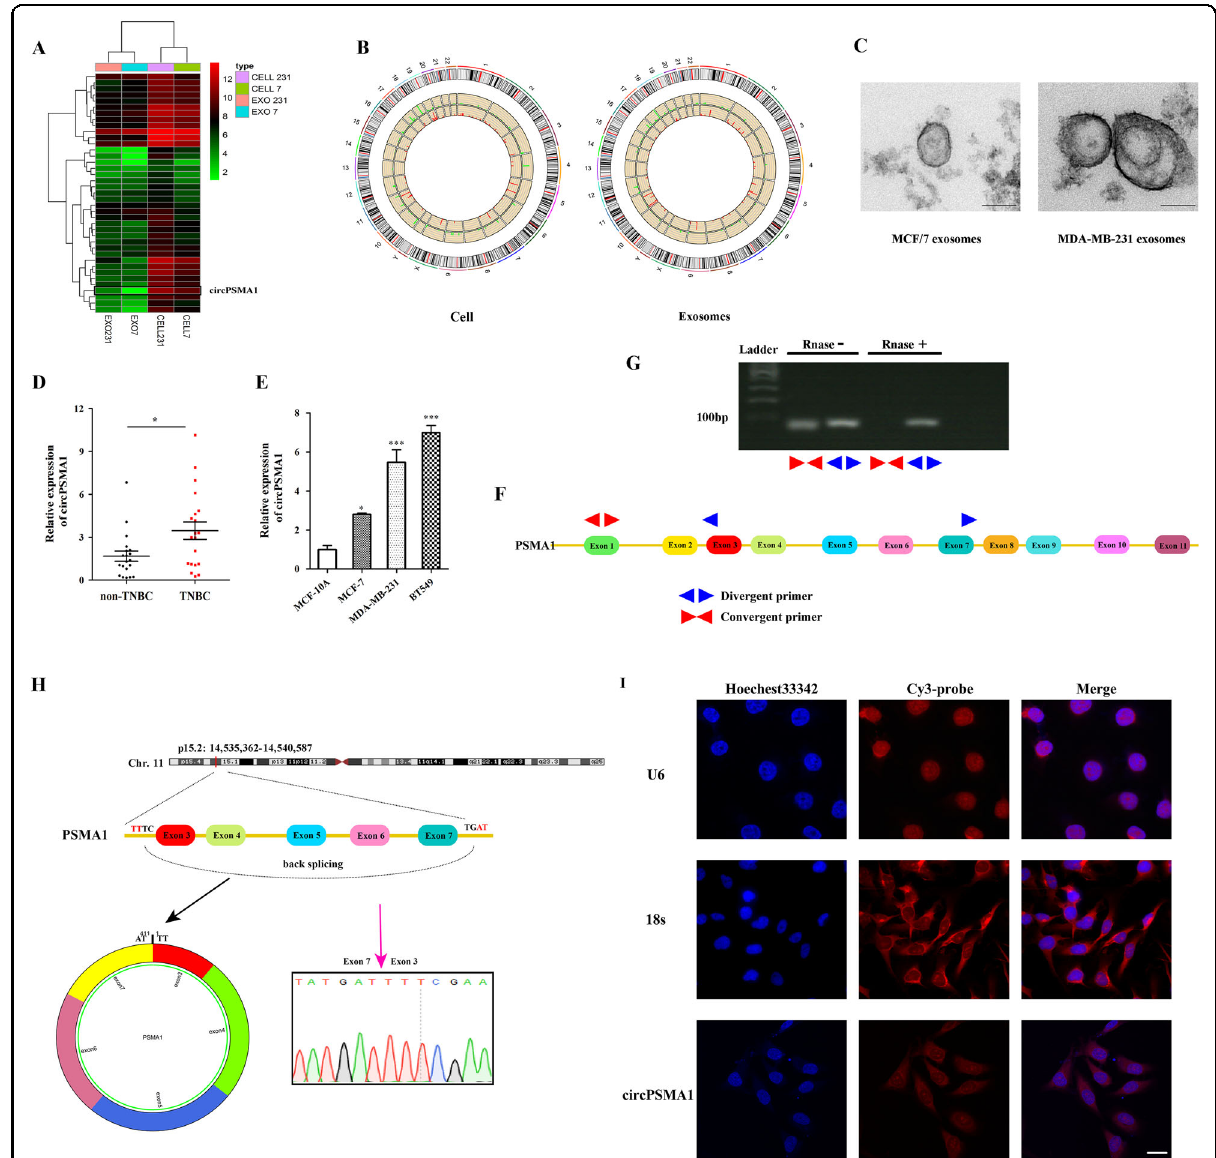
Fig. 1 Expression pro fi les of circRNAs in breast cancer cells and their exosomes and the characteristics of circPSMA1. A The expression pro fi les of the top 39 differentially expressed circRNAs in MDA-MB-231 cells (TNBC cell line) and their exosomes compared with MCF-7 cells (non- TNBC cell line) and their exosomes. Pseudo-colors (green to red) indicate the expression levels from low to high. B The signi fi cantly differentially expressed circRNAs represent in Circos diagrams generated by Circos (http://circos.ca/) with the threshold criteria of fold change > 2.0 and P < 0.05. Red bars indicate upregulated circRNAs, while blue bars represent downregulated circRNAs. The height of the bar means the fold change of the expression level of a circRNA. C Representative images of exosomes from MDA-MB-231 cells and MCF-7 cells using a transmission electron microscope (TEM). Scale bar, 100 nm. D The expression level of circPSMA1 was veri fi ed in serum exosome samples from TNBC patients ( n = 20) and non-TNBC patients ( n = 20) by qRT-PCR analysis. E The expression level of circPSMA1 was veri fi ed in TNBC cell lines (BT-549 and MDA-MB-231), non- TNBC cell lines (MCF/7 and MCF-10A). F The schematic illustrates the regions of qRT-PCR primers for the genomic loci of PSMA1 gene and circPSMA1. Convergent primer for detecting linear PSMA1 and divergent primers for circPSMA1. G Gel electrophoresis analysis of RT-PCR for the existence of circPSMA1 in breast cancer cells. CircPSMA1 is only ampli fi ed by divergent primers in cDNA treated with RNase. H The genomic loci of PSMA1 gene and circPSMA1. Red arrow indicates the back-splicing region of PSMA1 exon 3 to exon 7 veri fi ed by Sanger sequencing. The circPSMA1 spliced mature sequence length is 411 nt. I The FISH assay shows the subcellular localization of circPSMA1. The circPSMA1 probe is labeled with Cy3 (red) and nuclei is stained with Hochest 33342 (blue) (magni fi cation, ×200, Scale bar = 20 μ m). All data were shown as mean ± SD at least three independent experiments, * p < 0.05, *** p <